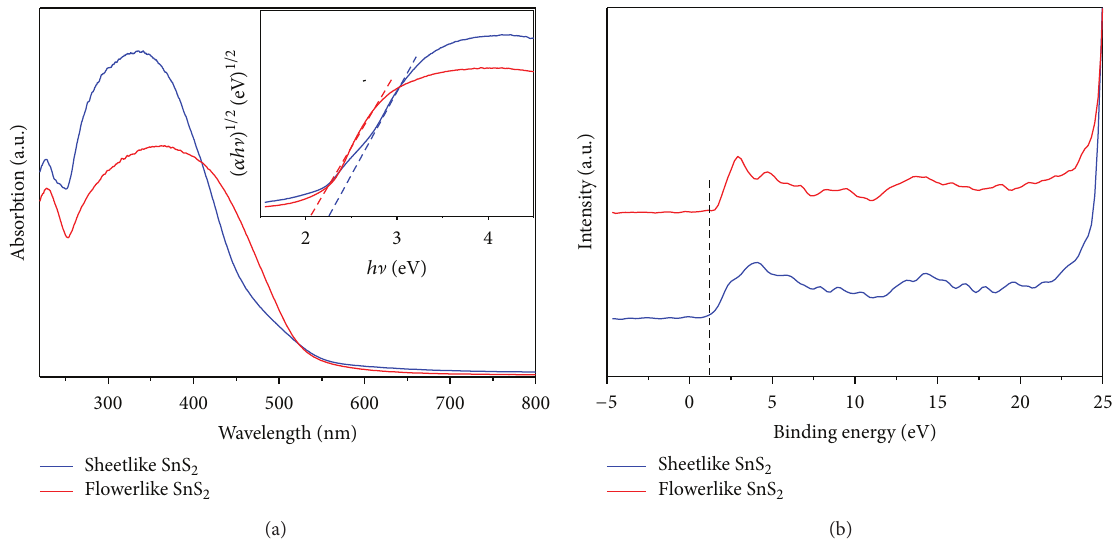
Figure 4: (a) UV-visible absorption spectra and corresponding plots of transformed Kubelka-Munk function versus the energy of photon (inset); (b) Valence-band XPS spectra of the two SnS 2